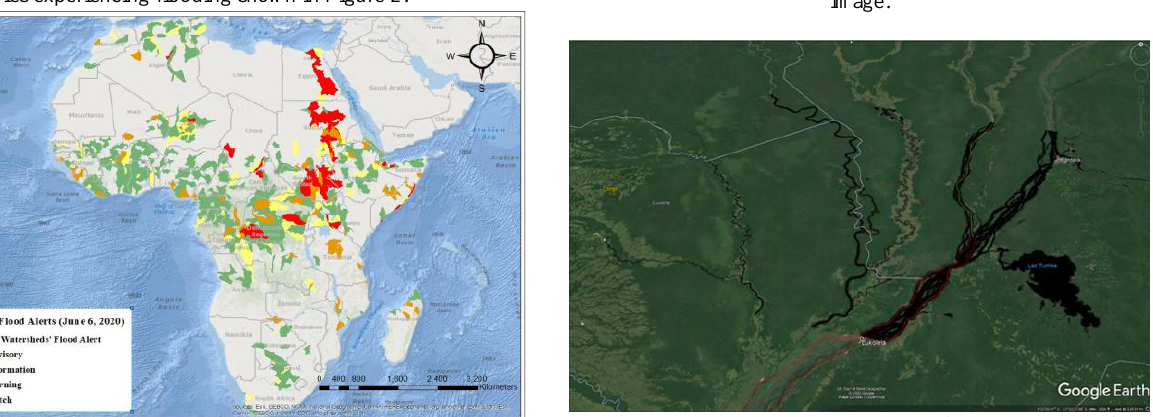
Figure 2. Watershed with flood alert within African Countries